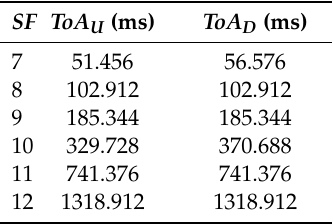
Table 3. Time-on-Air of each uplink and downlink message in the scenario with up to 32 mapped devices, for SF varying from 7 to 12. SF : Spreading Factor; ToA U : Uplink ToA; ToA D : Downlink ToA.